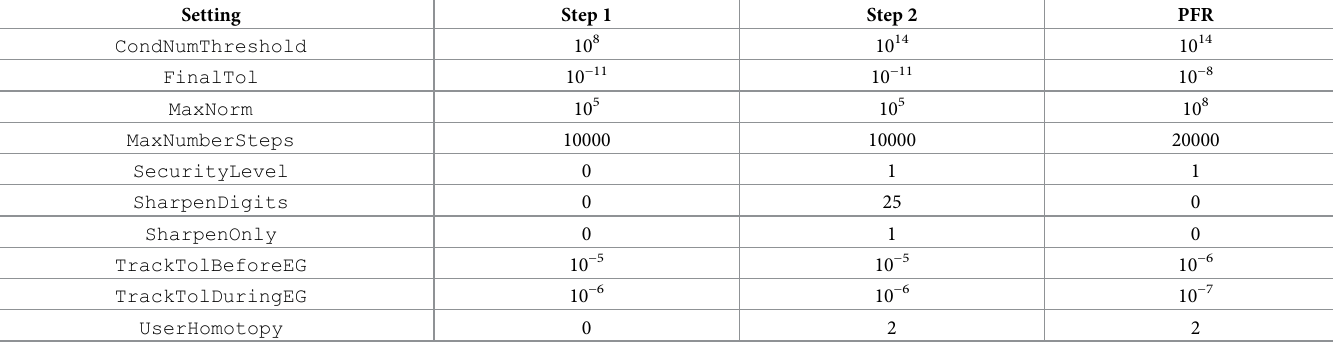
Table 3. First-pass Bertini settings. The principal settings used for the computational analysis are listed here. Every first-pass Paramotopy run was performed using these Bertini settings; all other settings were set to their default values [77]. The column title PFR refers to “path failure resolution” and this column gives Bertini setting values used for the first iteration of this process; the Bertini settings were modulated appropriately for subsequent iterations. A complete list of all Bertini settings used for every Paramotopy run and re-run, as well as all path failure resolution iterations, is given in S1 Dataset, with further details in S1 Appendix. Setting Step 1